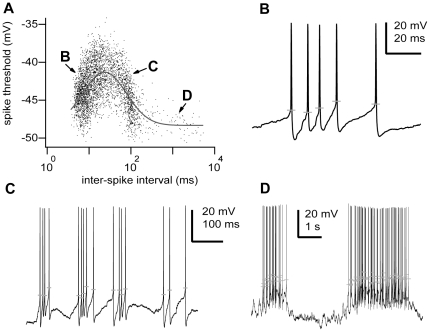
The voltage threshold of action potentials is a function of the preceding spike time interval.
A, Plot of the action potential voltage threshold versus the time (in logarithmic scale) since the last action potential recorded in a TRN neuron. The line is the best-fit line by the log-normal function y(V) = 48.33 mV+7.03 mV*exp[−(ln(x(t)/23.52 ms)/1.64)2], n = 3644 spikes, p<0.001, Kolmogorov-Smirnov test. B–D, Three interval ranges in the log-normal distribution correspond to discrete physiological intracellular states of activity. B, high-frequency burst discharge; C, inter-burst discharge periods; and D, inter-network active periods. Grey horizontal lines show for each spike the voltage threshold. Scale bars: B, vertical 20 mV, horizontal 20 ms; C, vertical 20 mV, horizontal 100 ms; D, vertical 20 mV, horizontal 1 s. Some portions of raw data (intracellular voltage recordings) from the cell in this figure have been used in previous publications (see Methods).